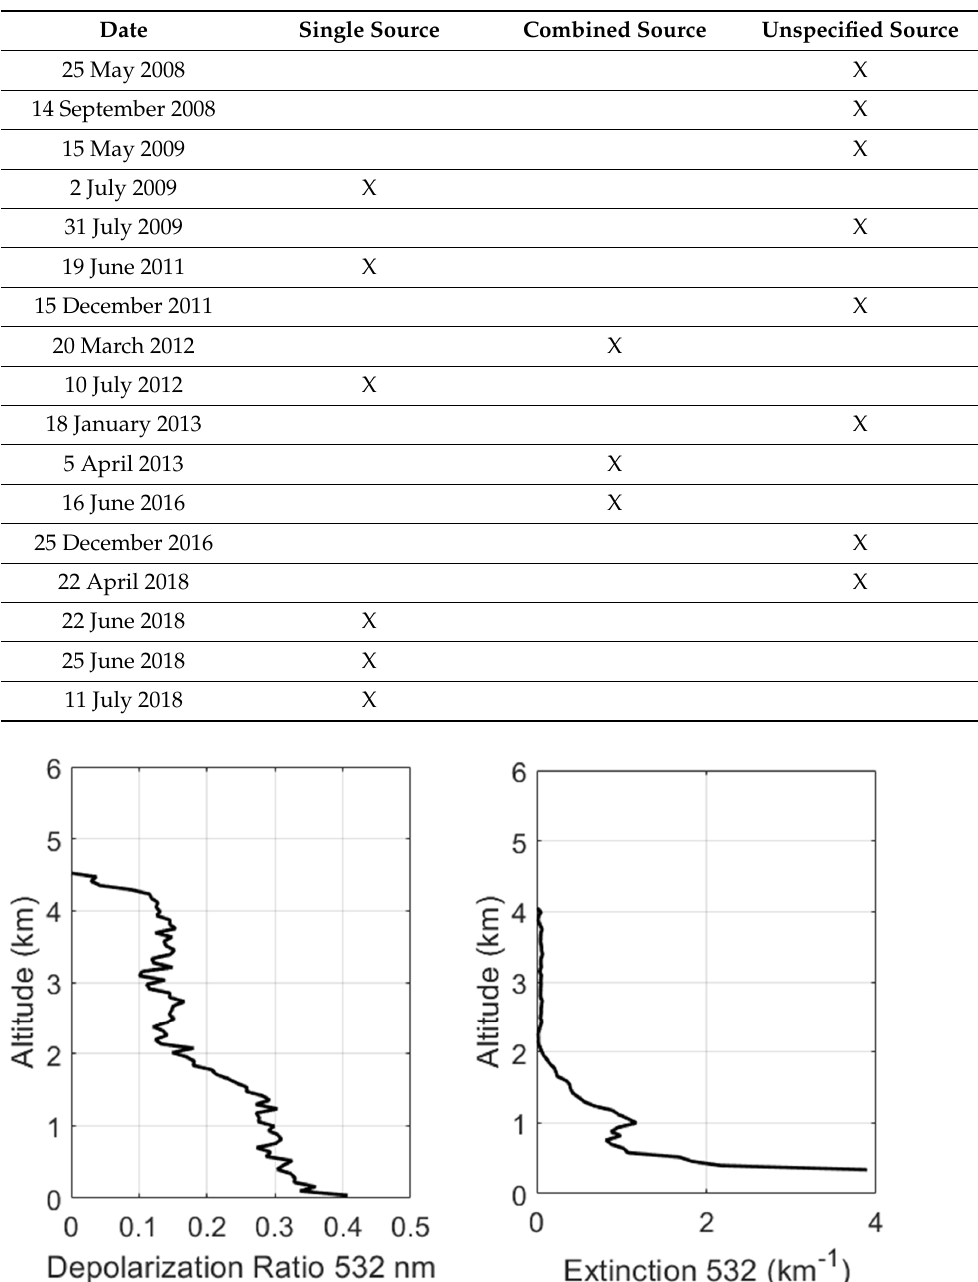
Table 2. The SDS cases studied: dates and their classifications.